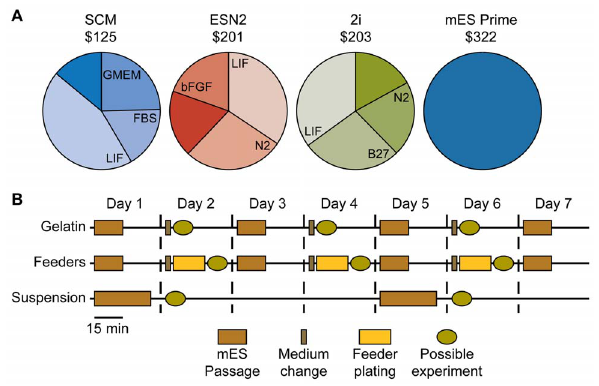
Figure 7. Cost and hands-on time for different ES cell culturing protocols. (A) Cost comparison and the three most expensive constituents for 500 ml ready-to-use SCM, 2i and ESN2 media (based on the list price for medium-sized bulk purchases), and the mES Prime Kit. (B) Estimated minimum cell maintenance hands-on time and possible experimental set-ups for seven days of mES cultures on feeders and gelatin, or in suspension.